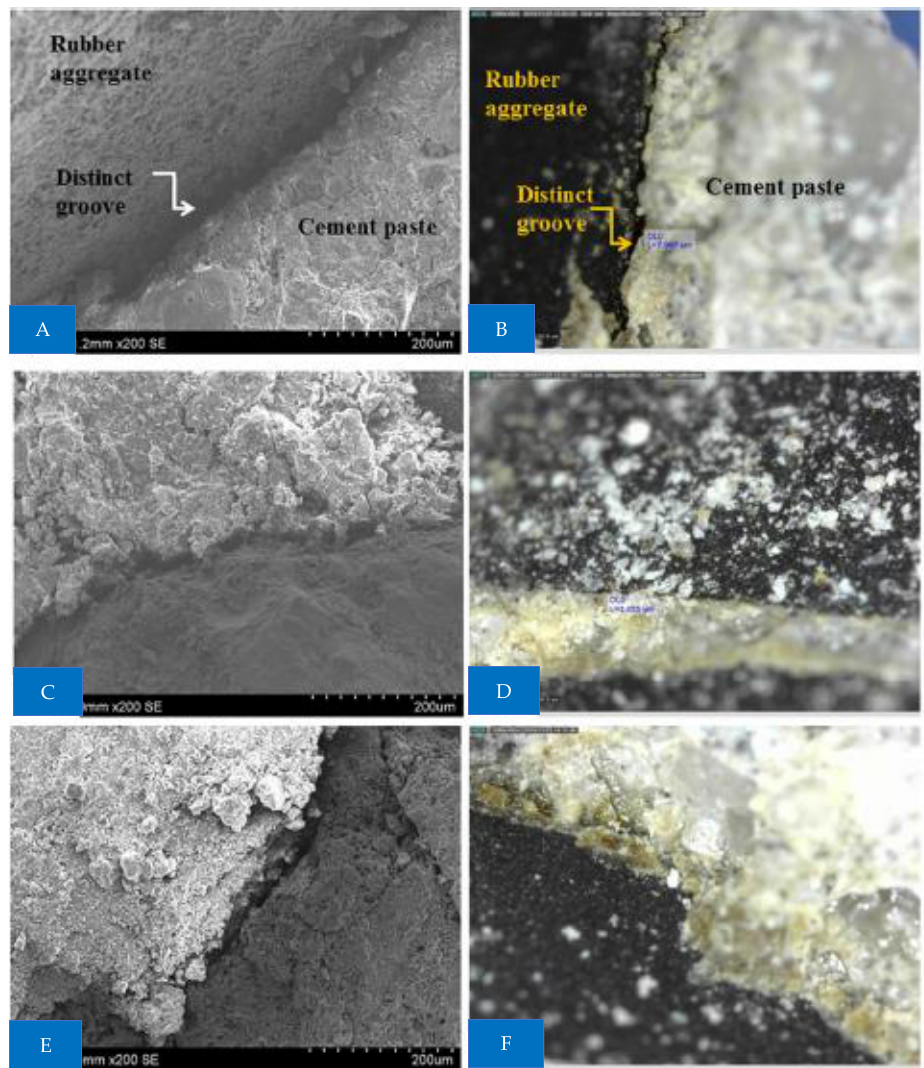
Figure 22. SEM results: ( A , B ) water, ( C , D ) NaOH treated, and ( E , F ) Ca(CIO 2 ) treated [39].